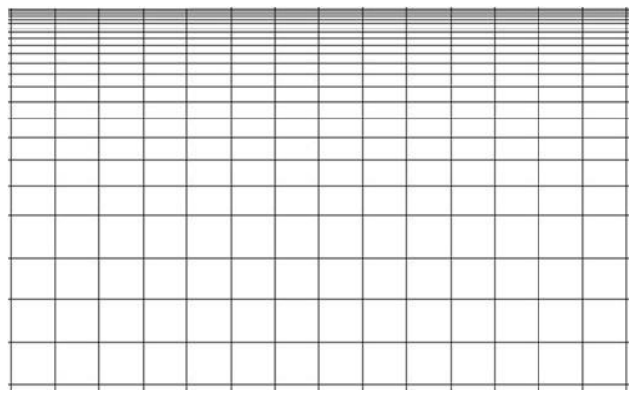
Figure 3. Computational